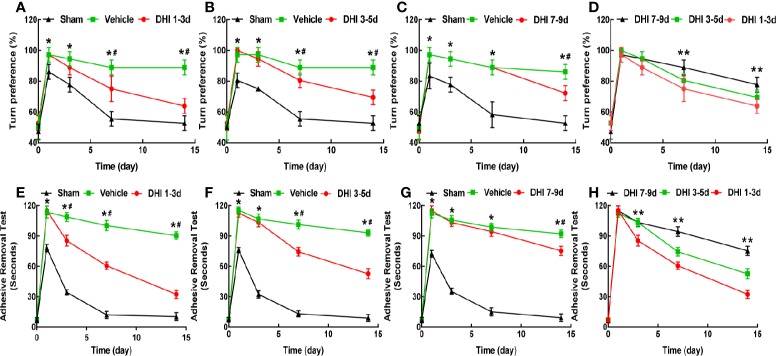
DHI treatment improves the turn bias and somatosensory deficits. DHI treatment significantly reduces the percentage of left turns in the corner turn test (A–C) and adhesive-removal time (E–G) after ICH. (D) The DHI administration on days 1–3 after ICH has a better effect on decreasing the percentage of left turns, when compared to the administration of DHI on days 3–5 or 7–9 (n = 6, P < 0.05). (H) The effect of DHI treatment on days 1–3 after ICH in reducing the adhesive-removal time was superior to the treatment performed on days 3–5 and 7–9 (n = 6, P < 0.05). (*P < 0.05 vs. sham; #P < 0.05 vs. vehicle; **P < 0.05 vs. DHI 3–5 or 7–9 days).